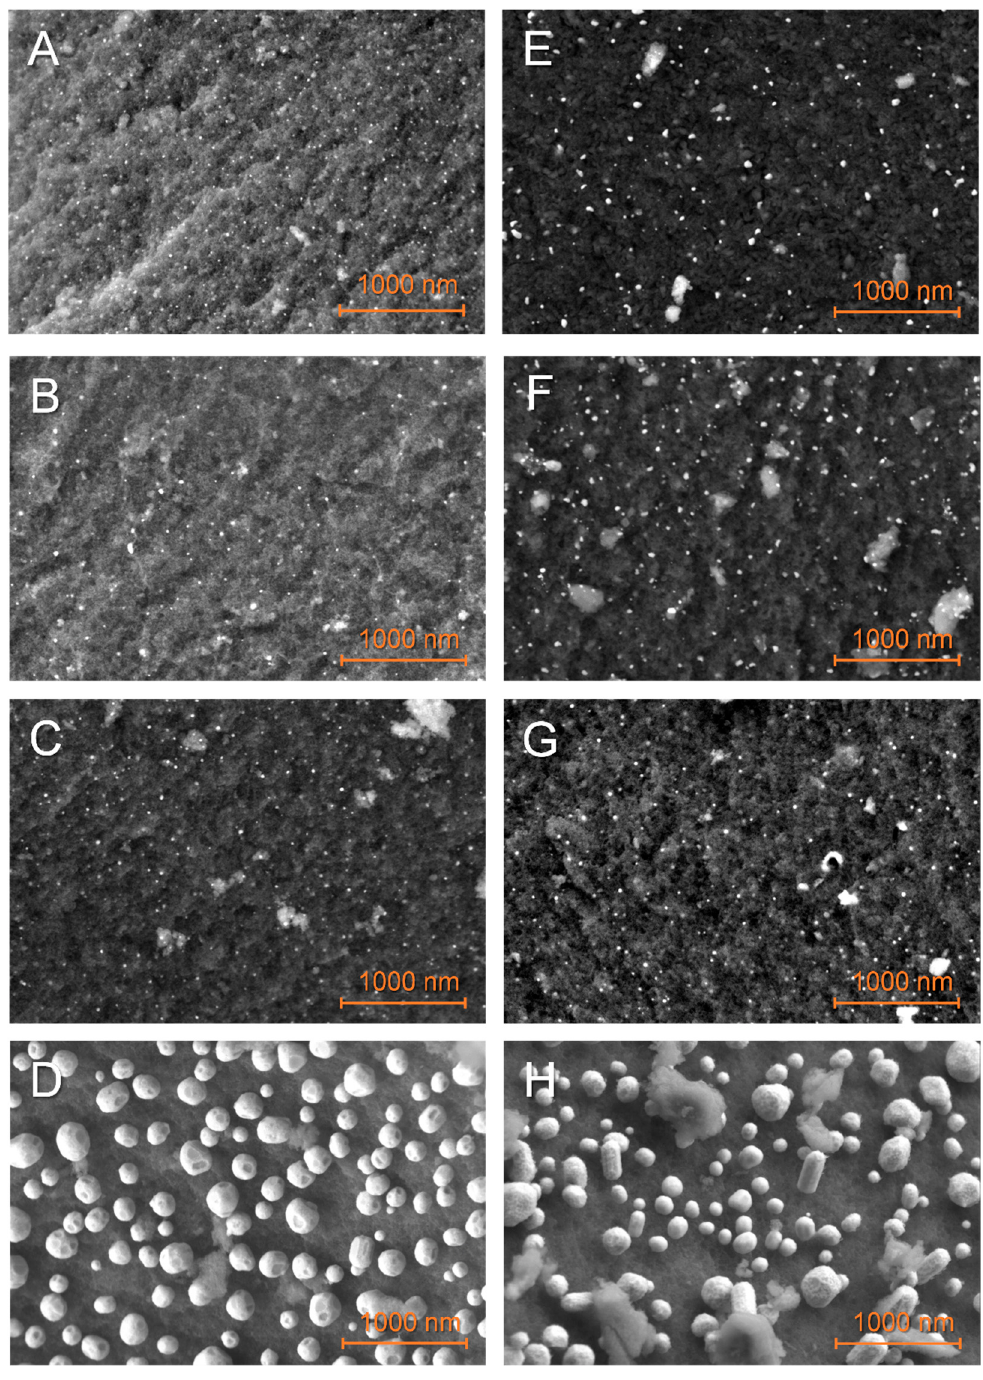
Figure 2. SEM observations of the non-impregnated GN ( A – D ) and G2N ( E – H ) matrixes decorated with Fe ( A , E ), Co ( B , F ), Ni ( C , G ), Cu ( D , H ) nanoparticles.